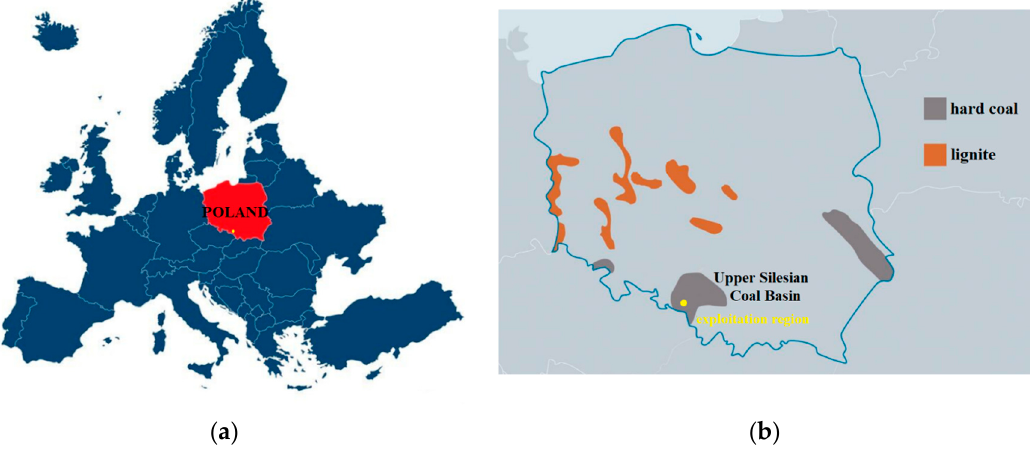
Figure 1. Location of an exploitation region on a map of: ( a ) Europe; ( b ) Poland.